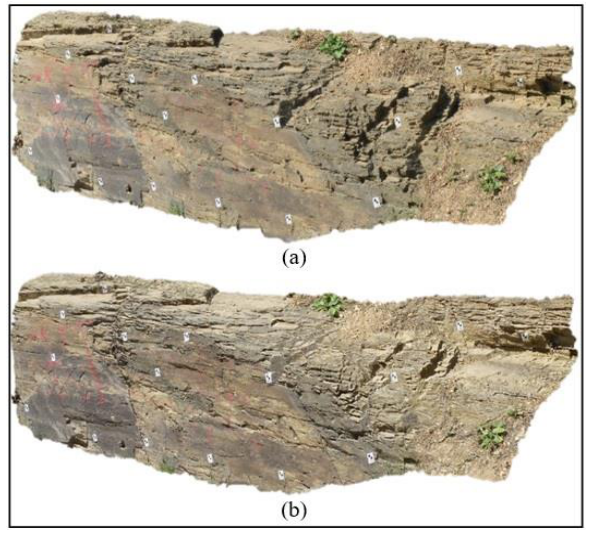
Figure 4. 3D object models produced by photographs taken by Nikon D700 (a) and Sony a6000